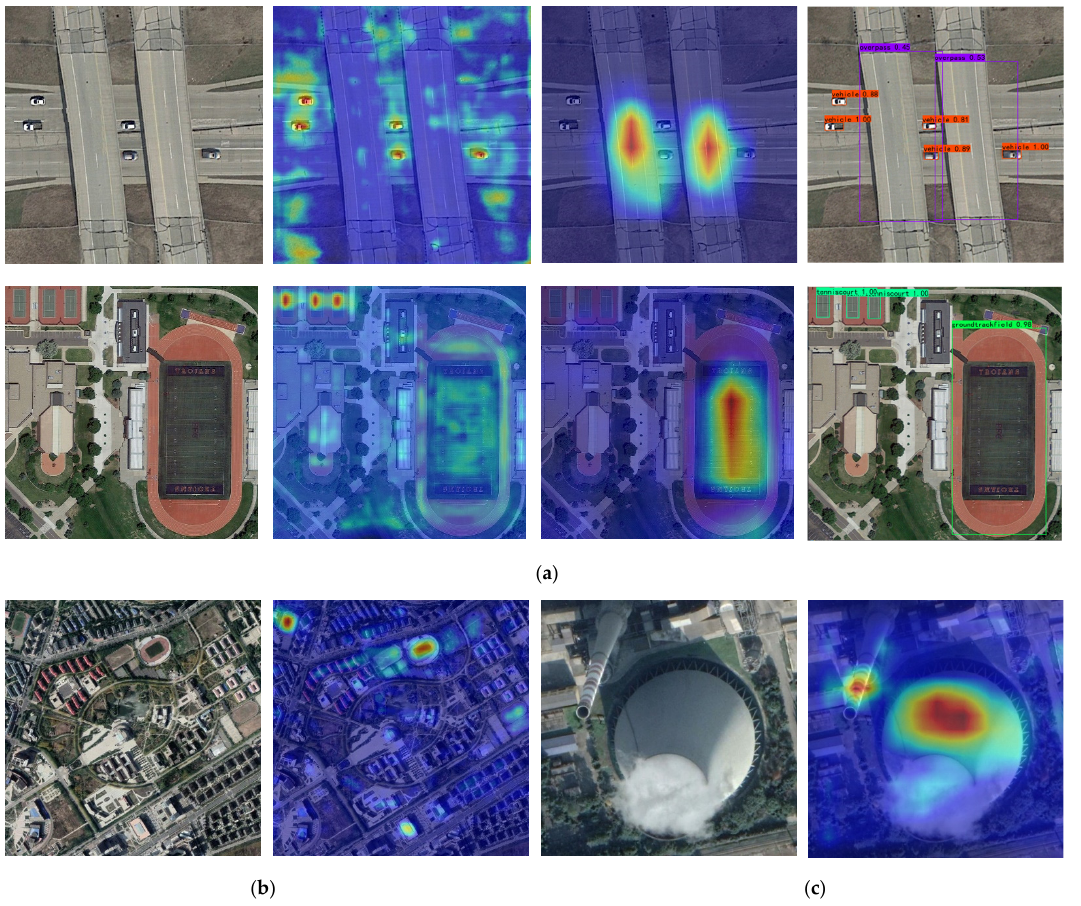
Figure 9. Visualization of object diversity. ( a ) Multiscale objects of different categories. ( b ) Small-scale athletic field. ( c ) Different appearance of the chimney.